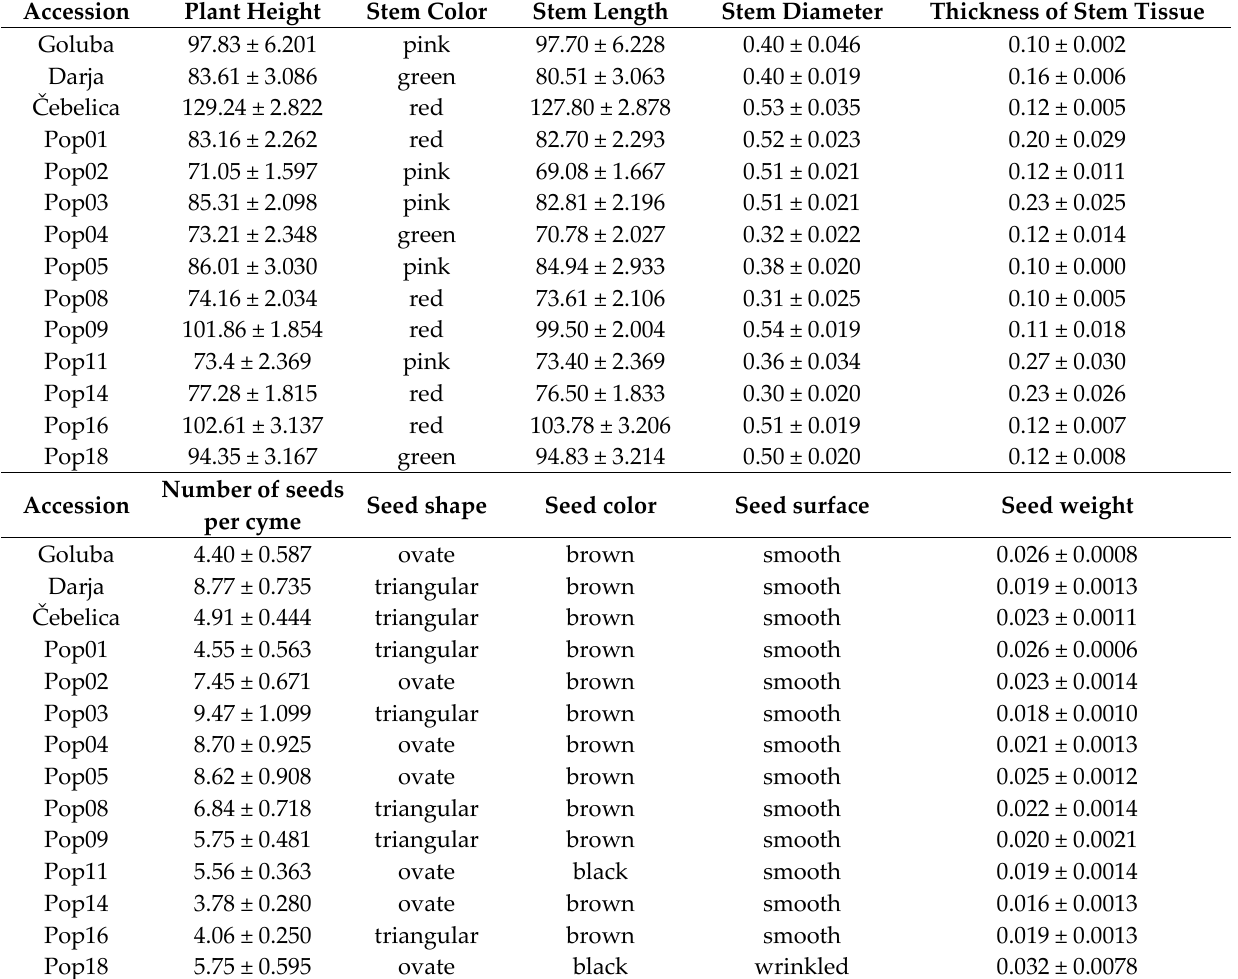
Table 2. Most important quantitative and qualitative traits of the analyzed common buckwheat ac ‐